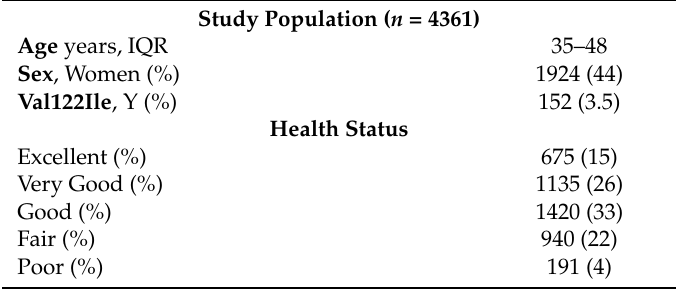
Table 1. Characteristics of the study population. IQR: Interquartile